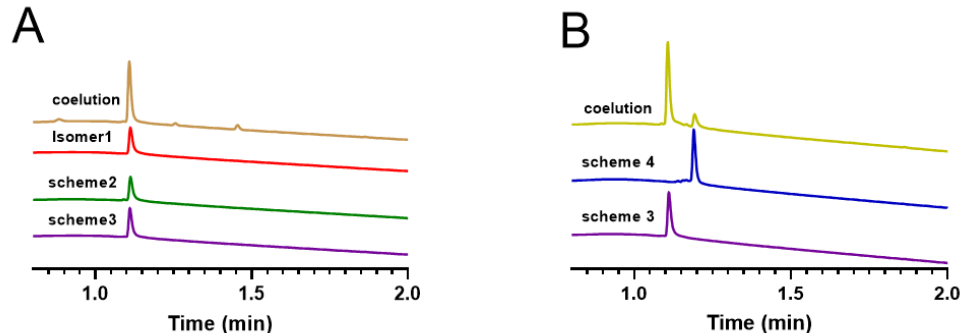
Figure 10. RP − UPLC analysis of oxidation products obtained by different synthetic strategies and products obtained by changing the position of the protecting group. ( A ) Isomer1 ( red ) coeluted with products of scheme 2 (green) and products of scheme 3 (purple). ( B ) The synthesized isomers of scheme 3 and scheme 4.